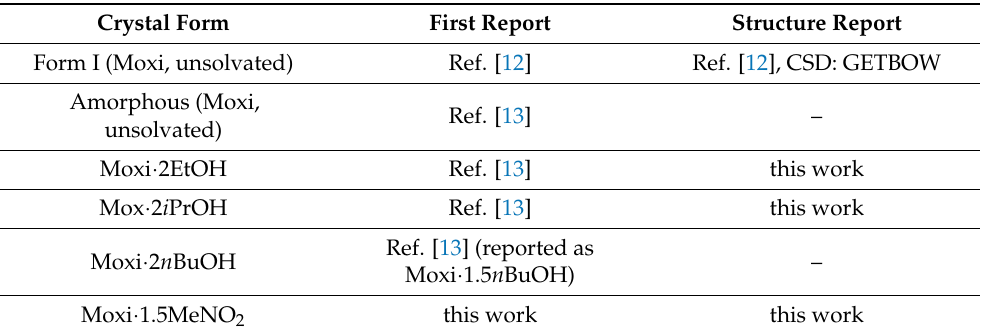
Table 1. Synoptic collection of moxidectin crystal forms as well as structural data and literature reports.